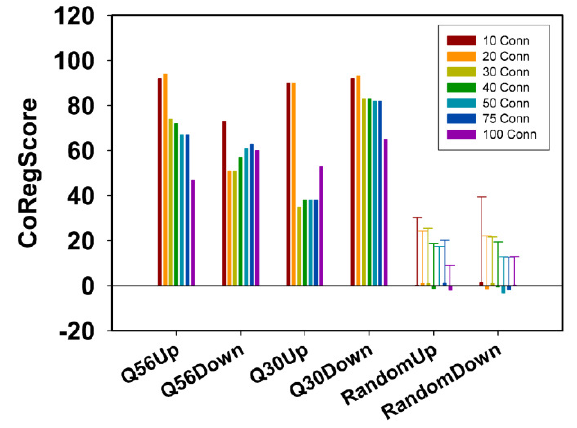
FIGURE 4: Analysis of connectors based on their real expression behavior. The CoRegScore evaluates to what extent connectors are regulated in the predicted direction. A positive score implies that the majority of algorithm-determined connectors are regu- lated in the same direction as the top100-hits. To obtain a CoReg- Score of 100, the predicted connectors have to be the next genes after the top100 in terms of expression differences. The CoReg- Score is calculated as described in the materials and methods section. Depicted here is the variability of the CoRegScore de- pending on the number of connectors derived from the pairwise co-regulation matrix. 100 random experimental sets were con- structed and evaluated under the same conditions to obtain the average score of a random data set and the standard deviation of this